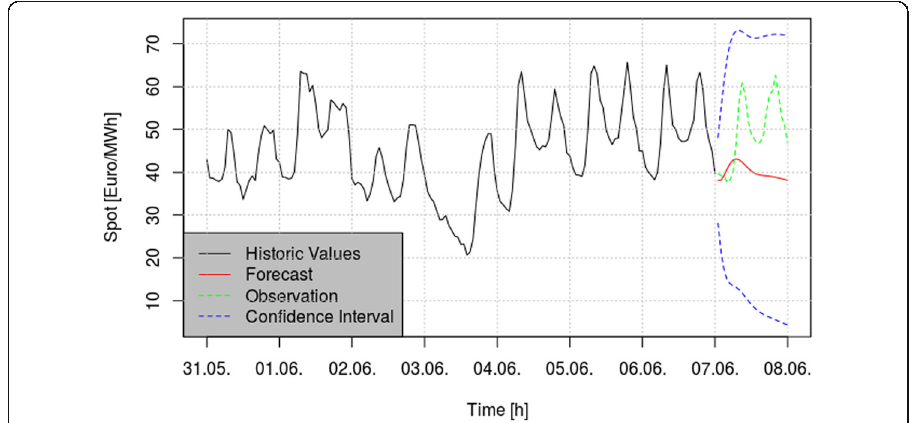
Fig. 2 Forecast of day-ahead prices of June 7th